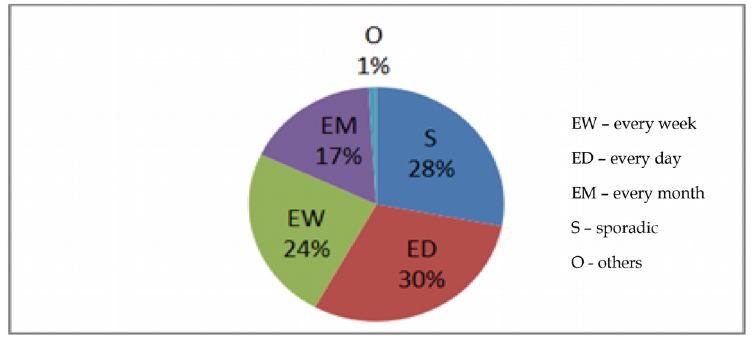
Figure 1. The frequency of students